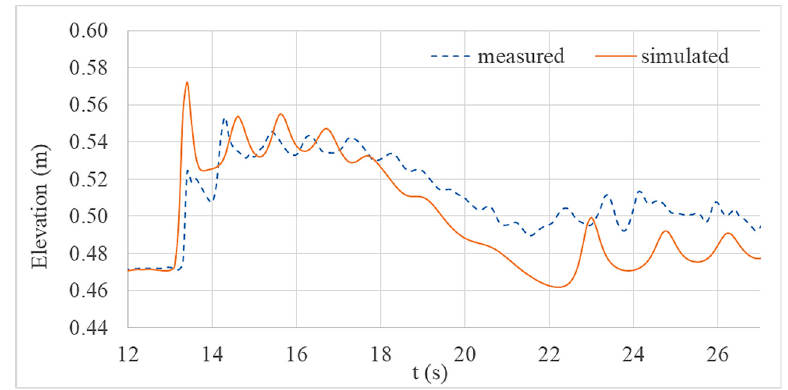
Figure 5. Comparison of water level variations at location B.